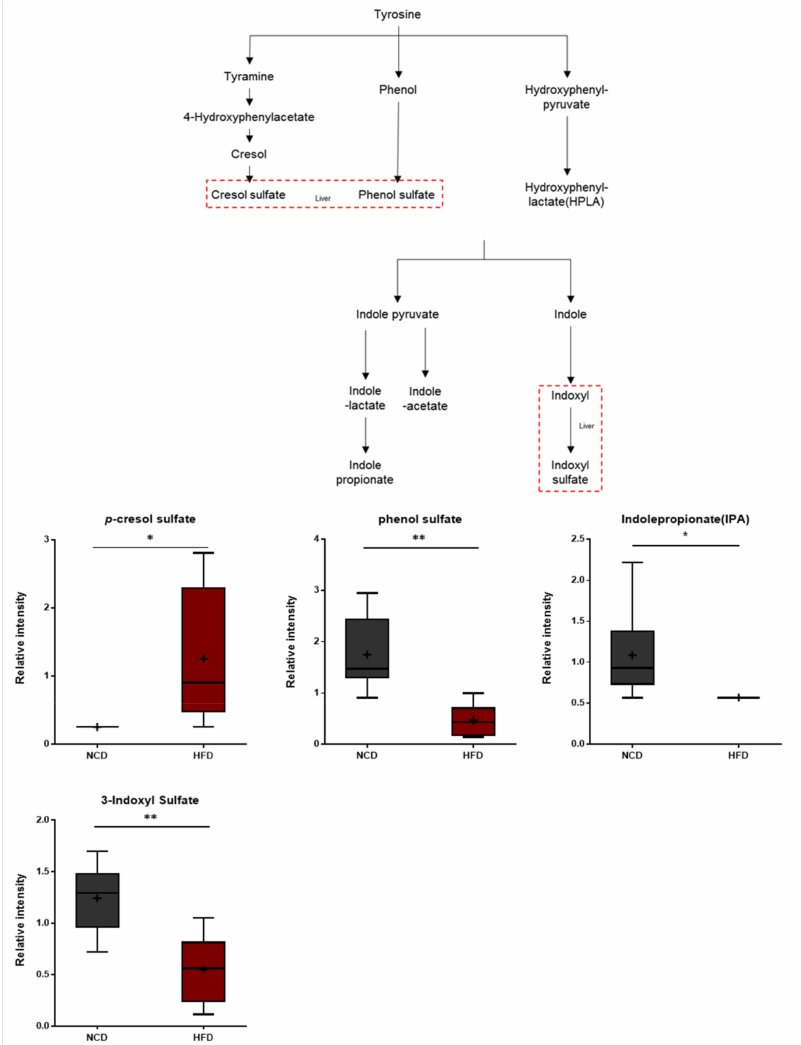
Figure 10. Pathway of statistically significant biochemicals profiled between NCD group and HFD group. Gut microbiome-derived metabolites such as p -cresol sulfate, phenol sulfate, indole propionate, and 3-indoxyl sulfate were altered in the HFD group. Data were presented as mean ± SD ( n = 6) and two-way ANOVA with Bonferroni’s multiple comparison test. * p < 0.05; ** p <